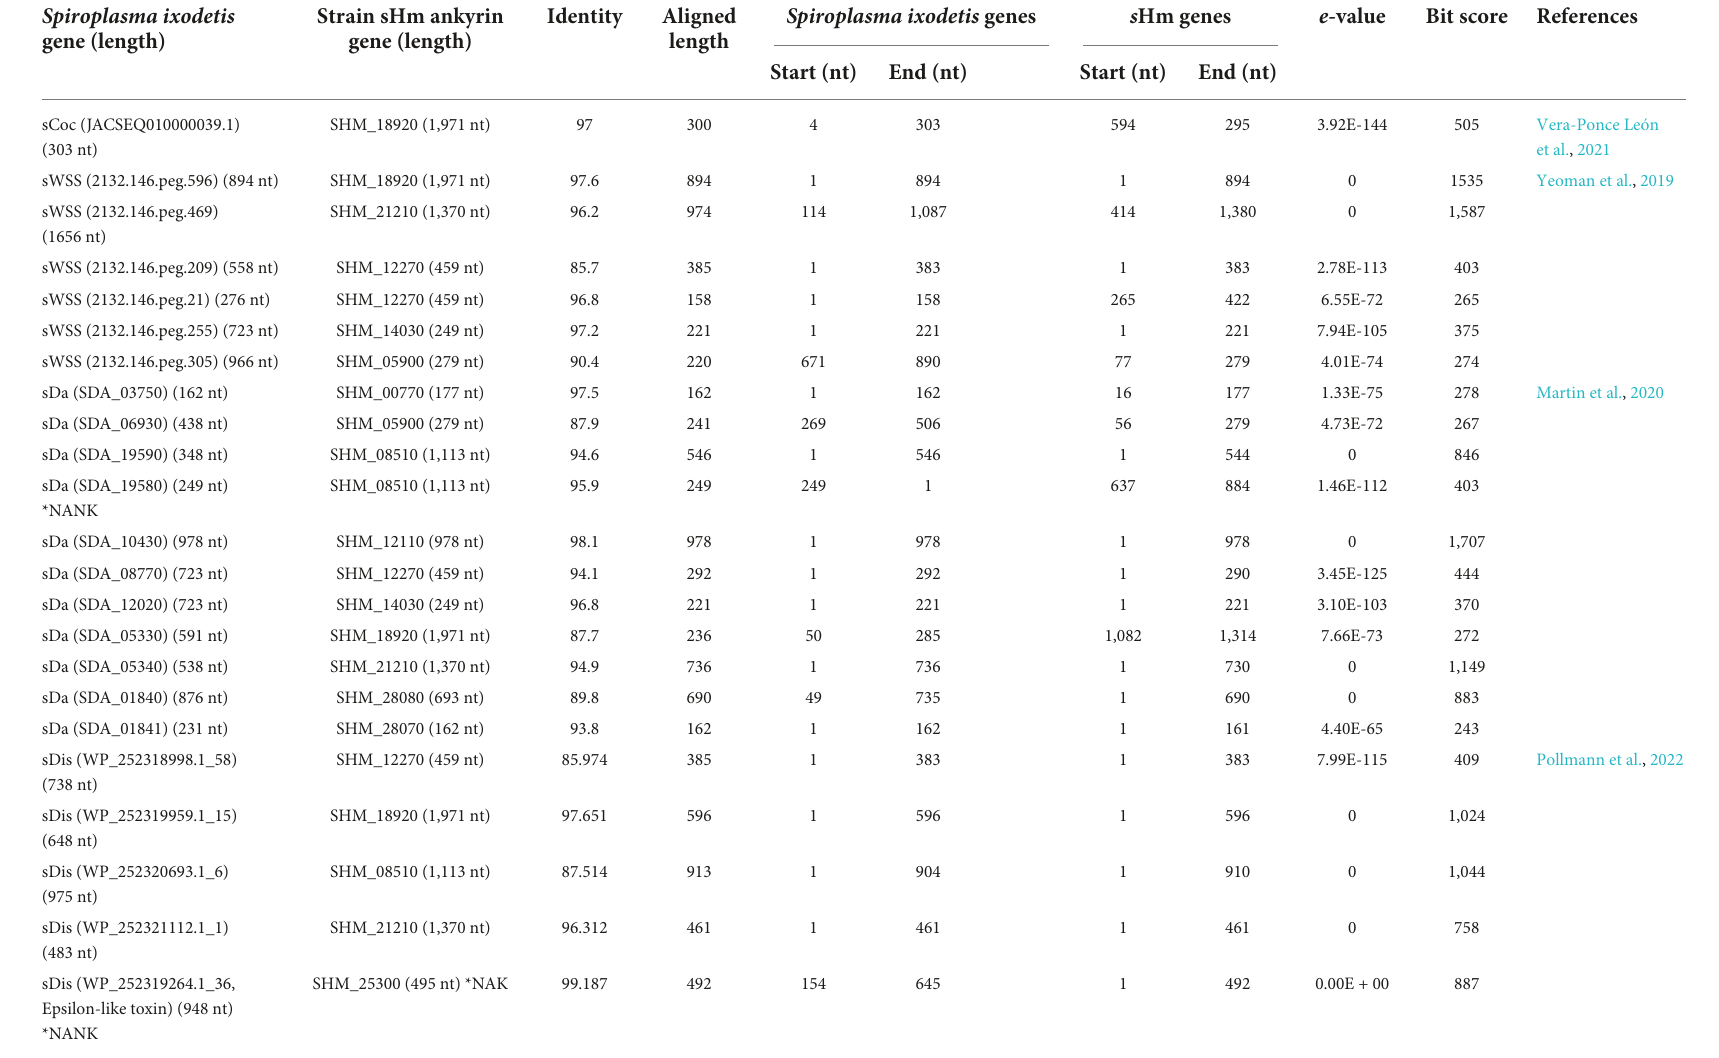
TABLE 4 Homology between ankyrin genes of two Spiroplasma ixodetis strains based on BLASTn search. Spiroplasma